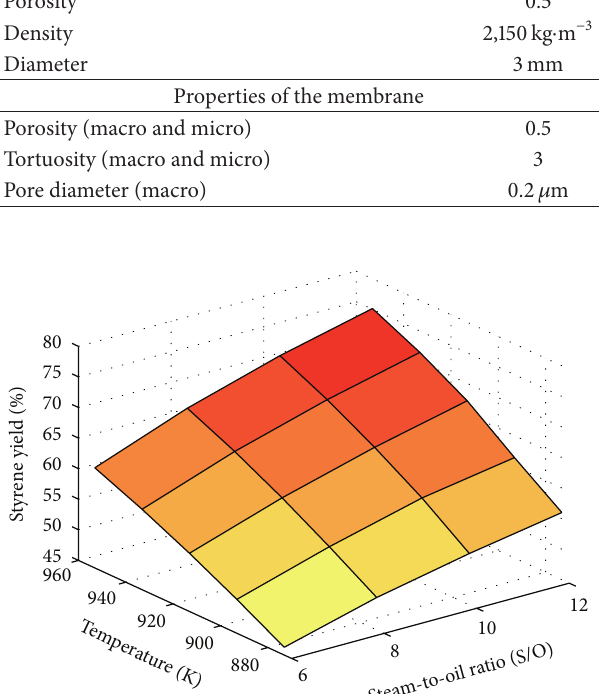
Figure 1: Influence of inlet temperature and steam-to-oil ratio on styrene